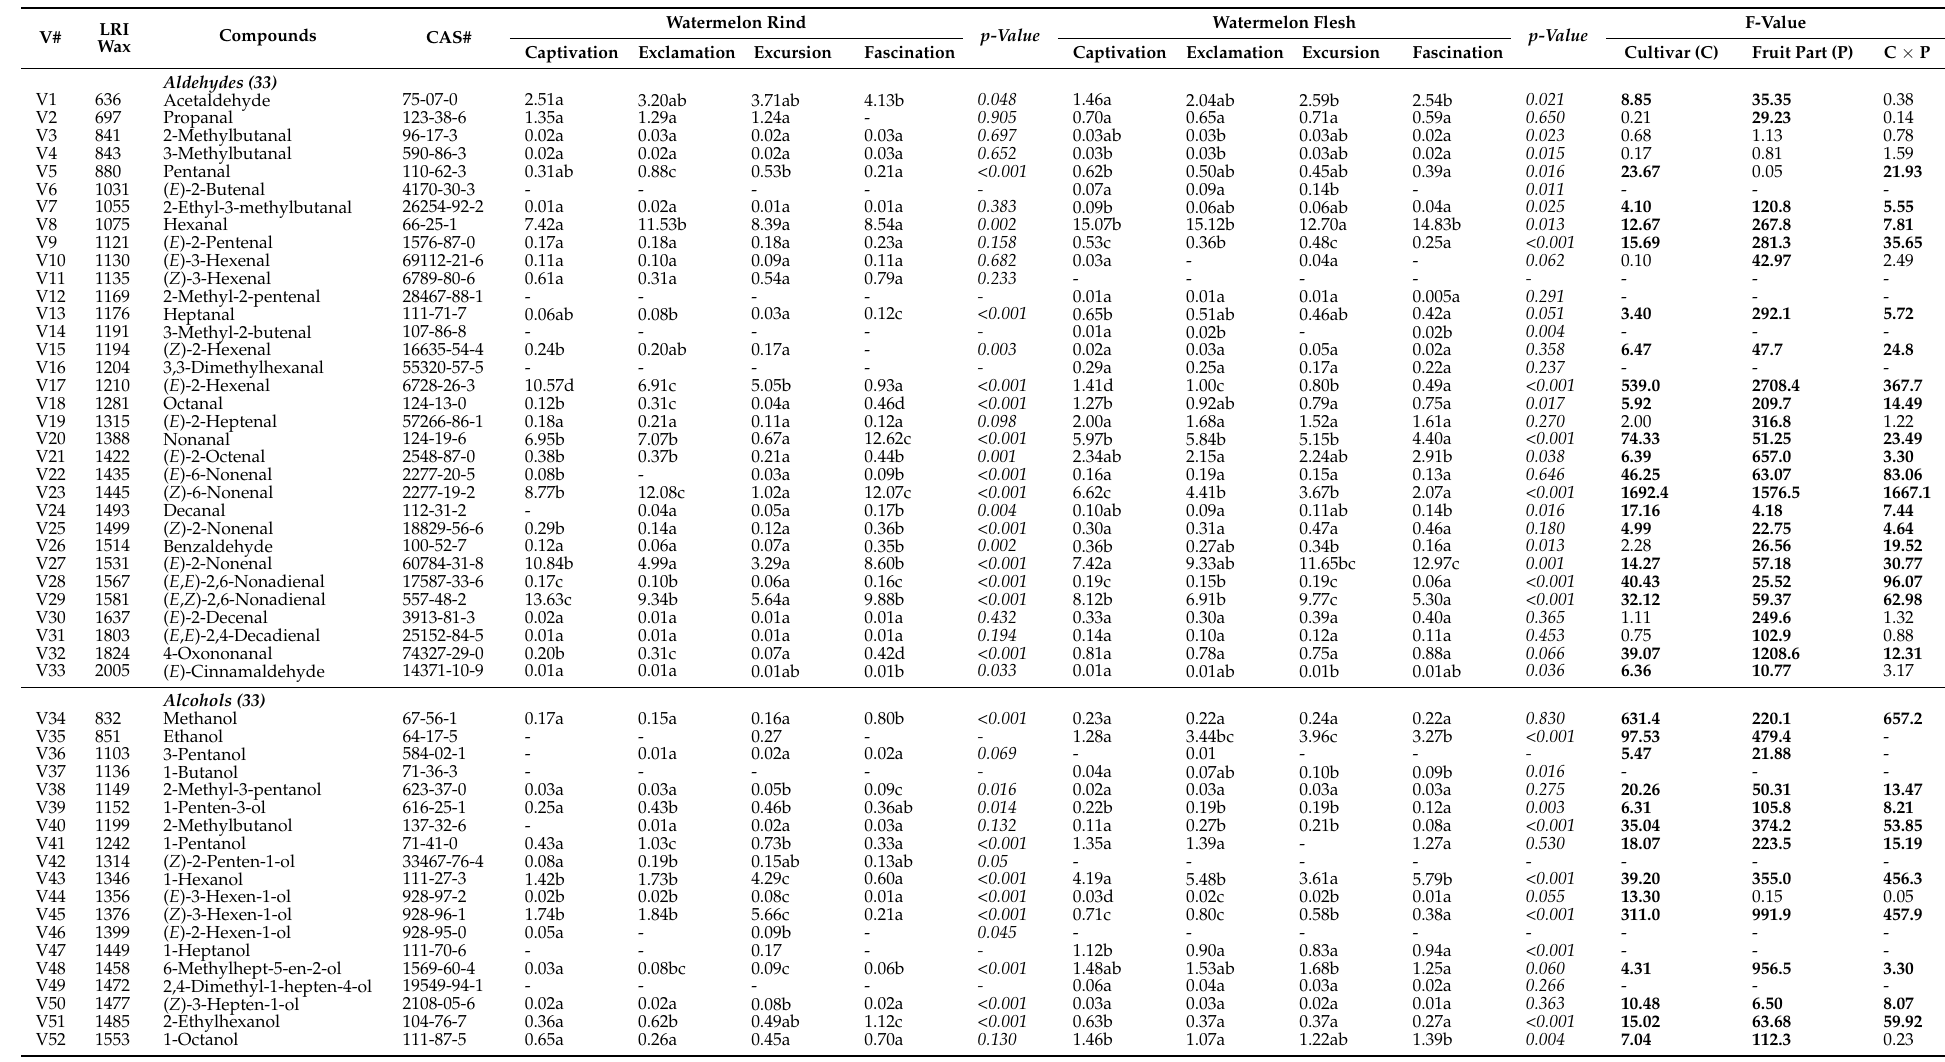
Table 1. Rind and flesh volatiles of Captivation, Exclamation, Excursion, and Fascination watermelon cultivars (% of peak